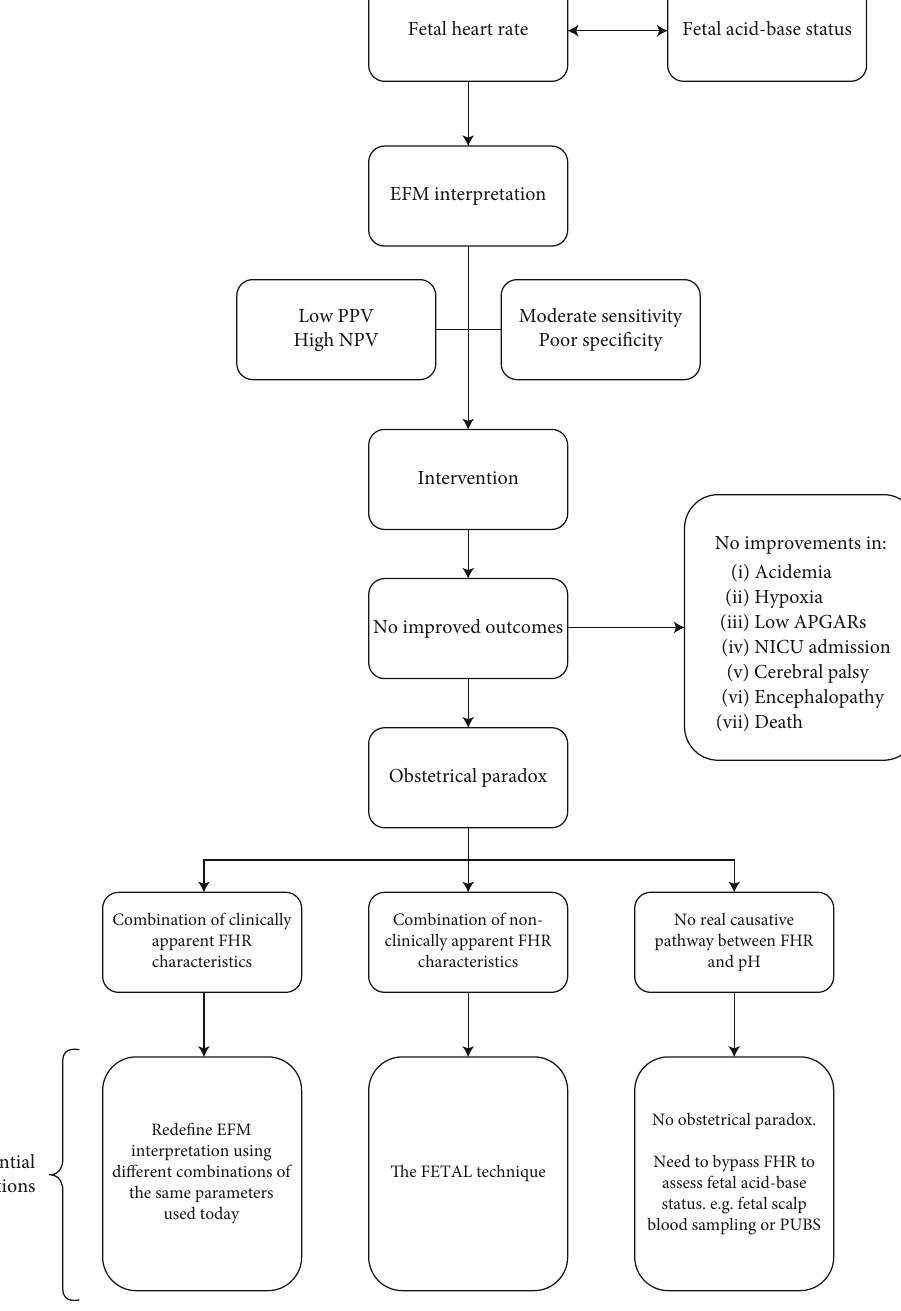
Figure 1: The obstetrical